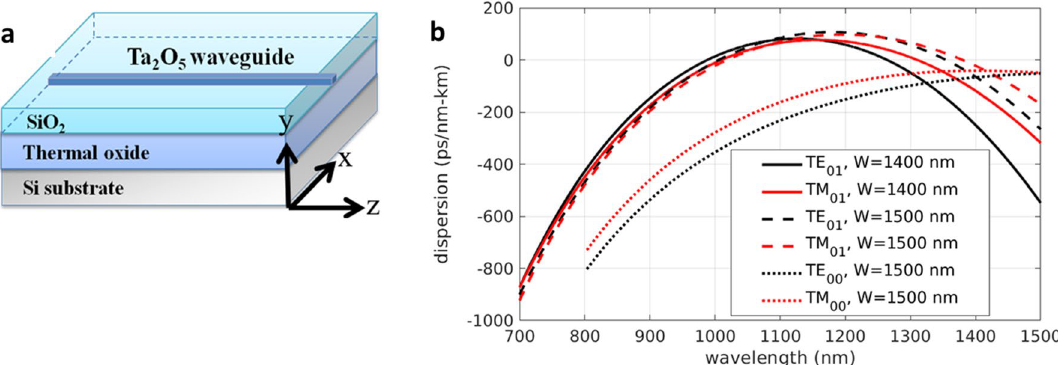
Figure 1. ( a ) Schematic of the structure of Ta 2 O 5 waveguide. ( b ) Calculated GVD for the higher-order modes of TE (x-) and TM (y-) polarizations in the Ta 2 O 5 waveguides of 1400 nm and 1500 nm